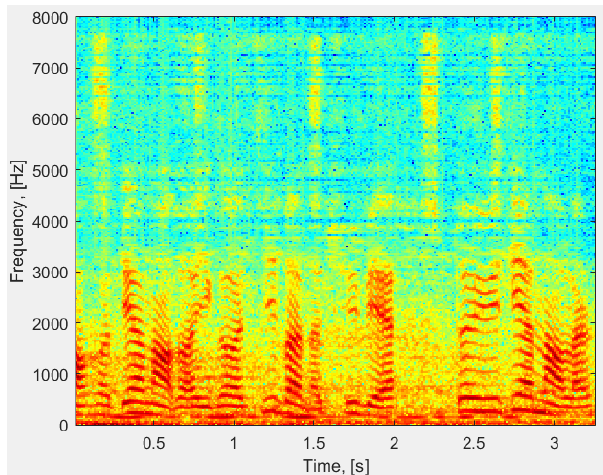
Figure 16. Spectrum of the separated speech by a male.